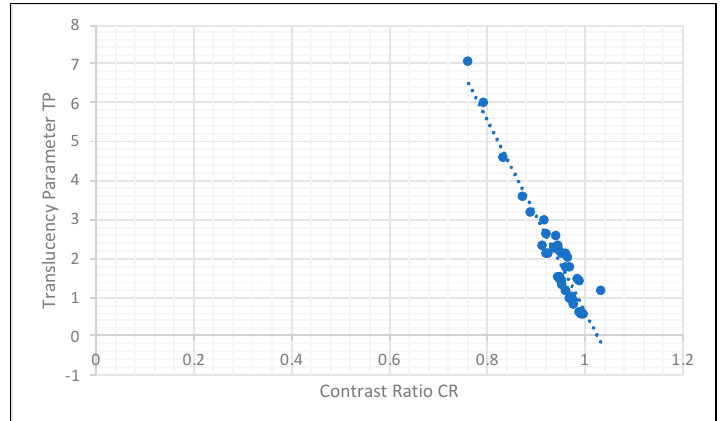
Figure 7. Correlation between translucency parameter and contrast ratio.